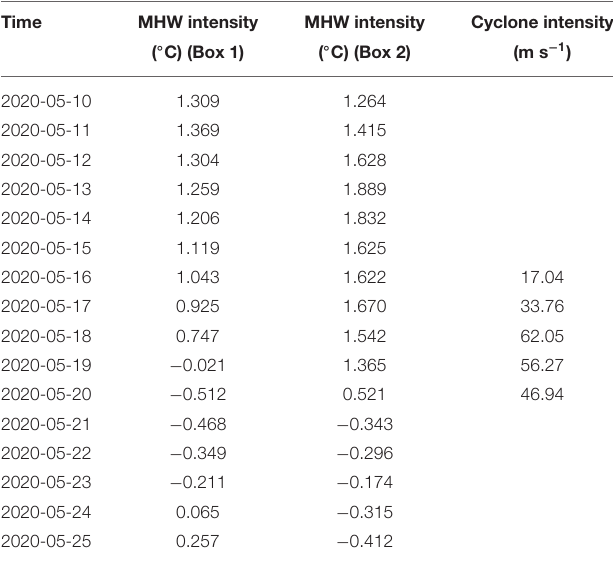
TABLE 1 | Daily mean Intensity of the marine heatwave ( ◦ C) and cyclone (m s − 1 ) averaged over box 1 and box 2 from 10 to 25 May 2020. Time MHW intensity MHW intensity Cyclone